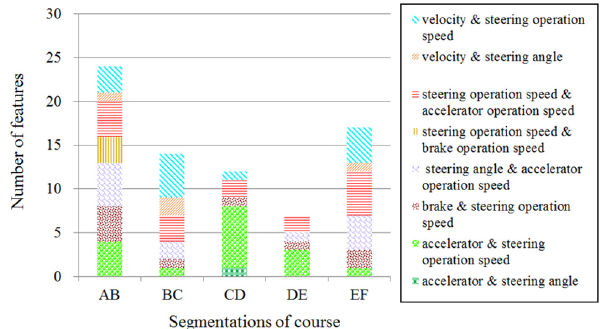
Figure 9 Features distribution in curve